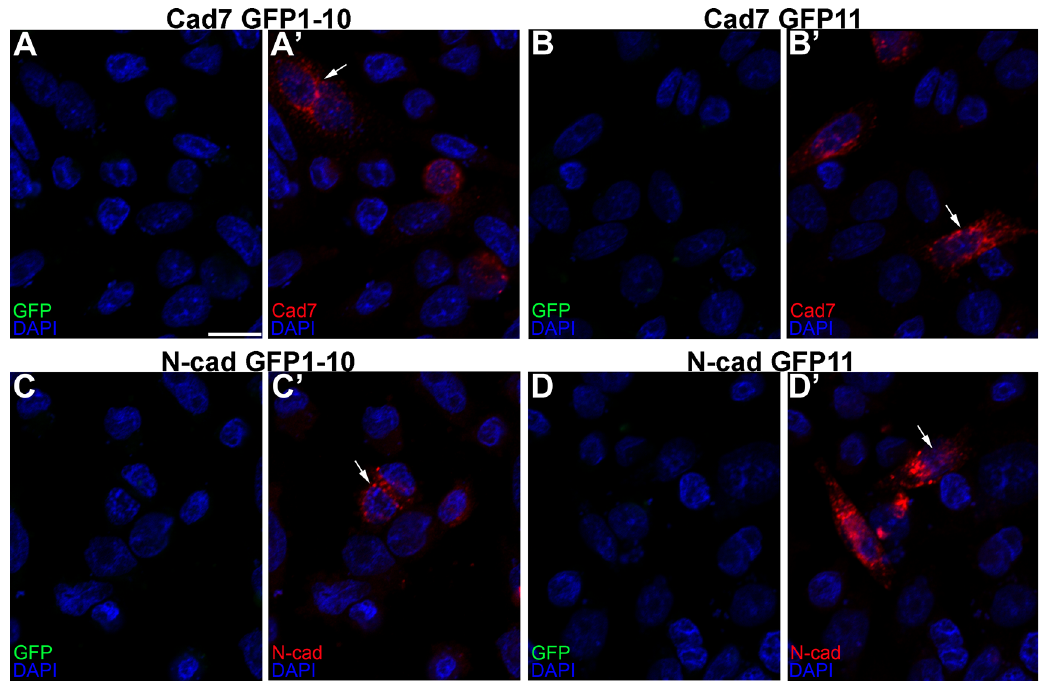
Figure 3. Individual cadherin GRASP constructs express their respective cadherins but not GFP. Single trans- fections of Cad7 GFP1-10 (A-A ’ ), Cad7 GFP11 (B-B ’ ), N-cad GFP1-10 (C-C ’ ), and N-cad GFP11 (D-D ’ ) were conducted in CHO cells, followed by immunocytochemistry for Cad7 (A ’ , B ’ , red) or N-cad (C ’ , D ’ , red). GFP fluorescence was also examined in the appropriate microscope channel (488) but not observed. Arrows point to cadherin expression in transfected cells. DAPI (blue), cell nuclei. N=3 replicates for all treatments. Scale bar in (A) is 50 μ m and applies to all images. GFP, green fluorescent protein; GRASP, GFP reconstitution across synaptic partners; CHO, Chinese hamster ovary; N-cad, neural cadherin; Cad7, expression of each cadherin was observed once again (Figure 4A ”’ , B ”’ , arrows), but no GFP was reconstituted, reinforcing the specificity of the assay.